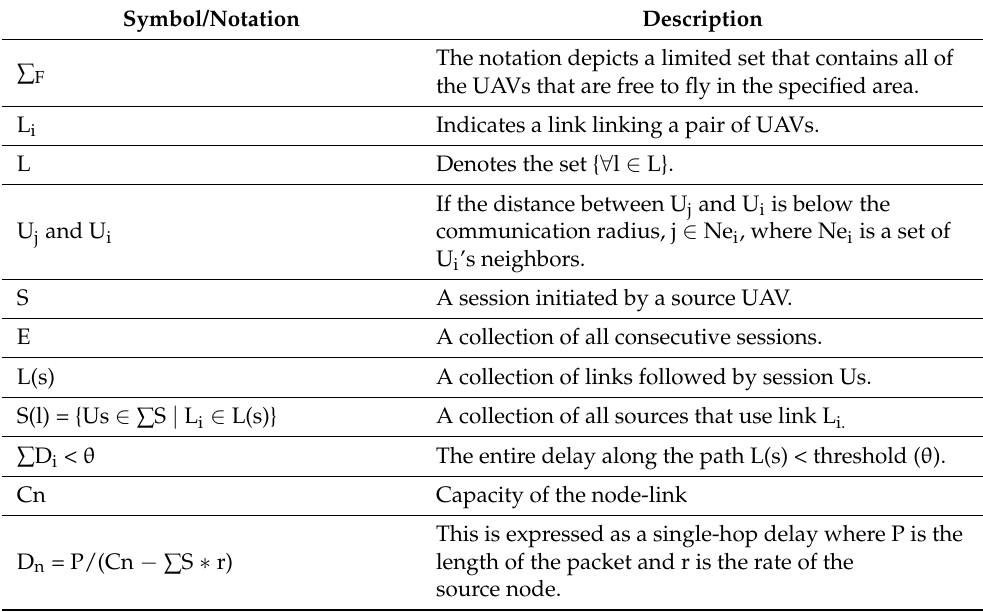
Table 2. Mathematical